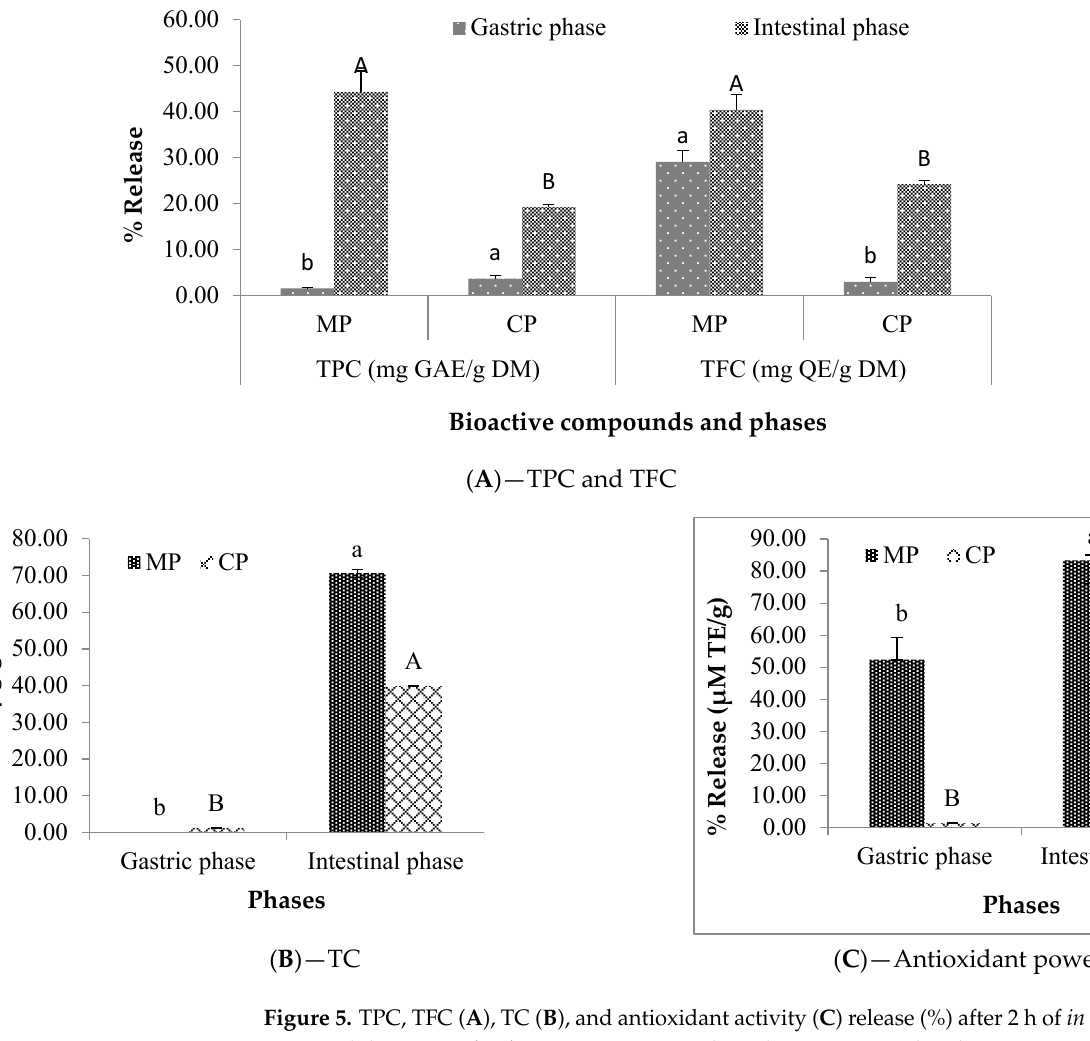
Figure 4. TPC, TFC ( A ), TC ( B ), and antioxidant activity ( C ) release (%) after 2 h of in vitro gastric and intestinal digestion of Ziziphus mauritiana crude and microencapsulated extracts. MP: Microen ‐ capsulated powder; CP: Crude powder; TPC: Total polyphenolic contents; TFC: Total flavonoid contents; TC: Total carotenoids. For each biocompound, the gastric phase averages that do not share any lower ‐ case letters are significantly different at the 0.05 threshold; the same applies to the aver ‐ ages of the intestinal phase that do not share any upper ‐ case letters.